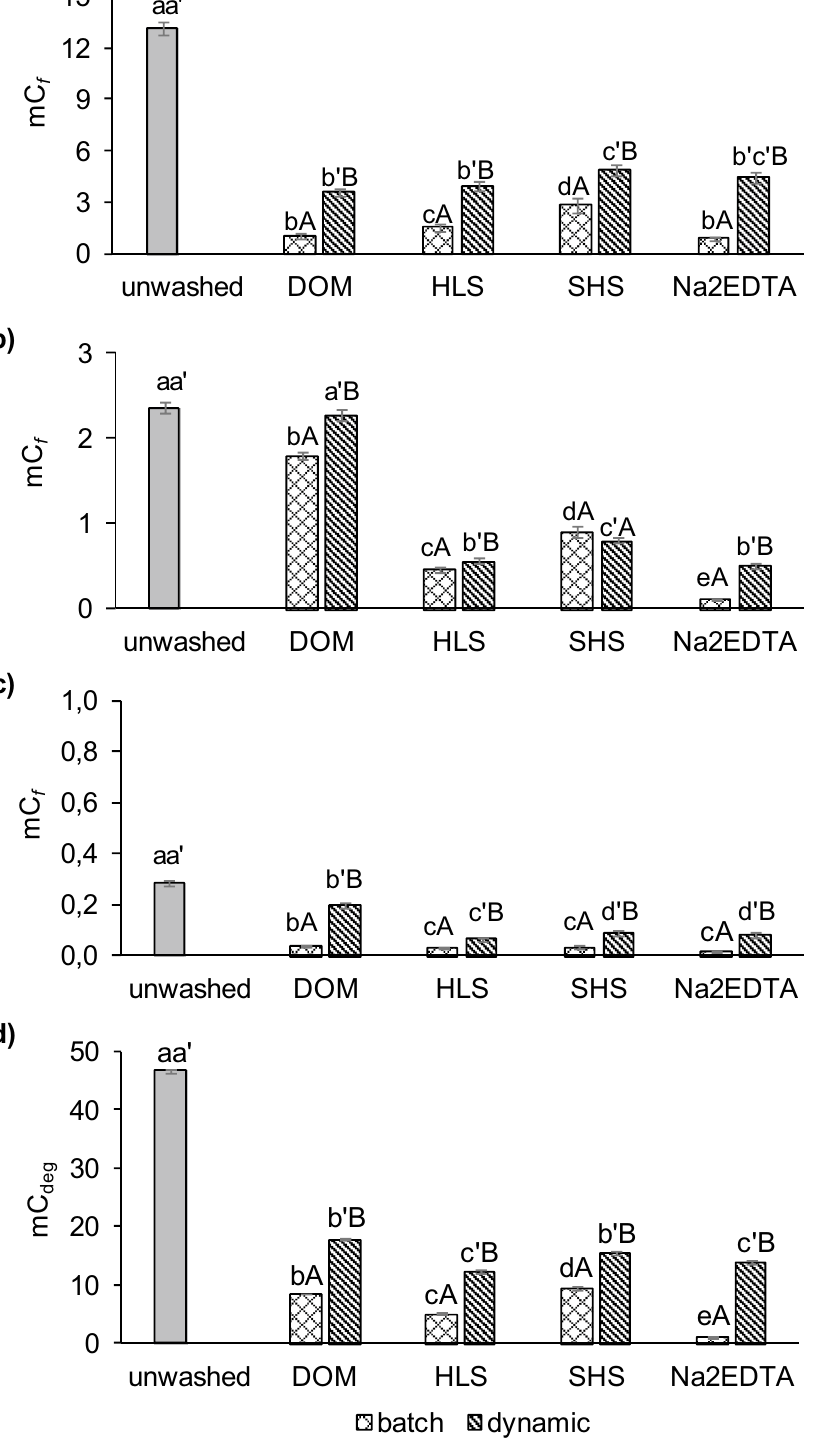
Figure 3. Assessment of the soil pollution with metals based on modified contamination factor (mC f ) and modified contamination degree (m C deg ): ( a ) mC f for Cu, ( b ) mC f for Pb, ( c ) mC f for Zn, ( d ) m C deg . Significant differences (mean ± SD, p < 0.05, Statistica 13.1) for mC f and m C deg between soils washed under batch conditions (abc), between soils washed under dynamic conditions (a’b’c’) and between washing conditions with the use of the same washing solution (AB) are marked with specific